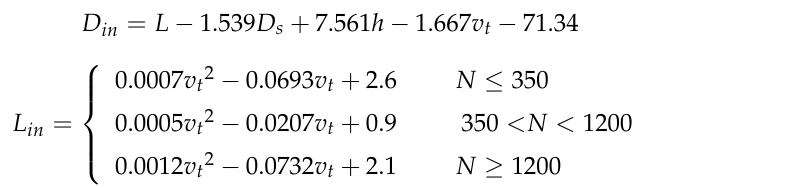
Figure 8. Tunnel lighting zones.